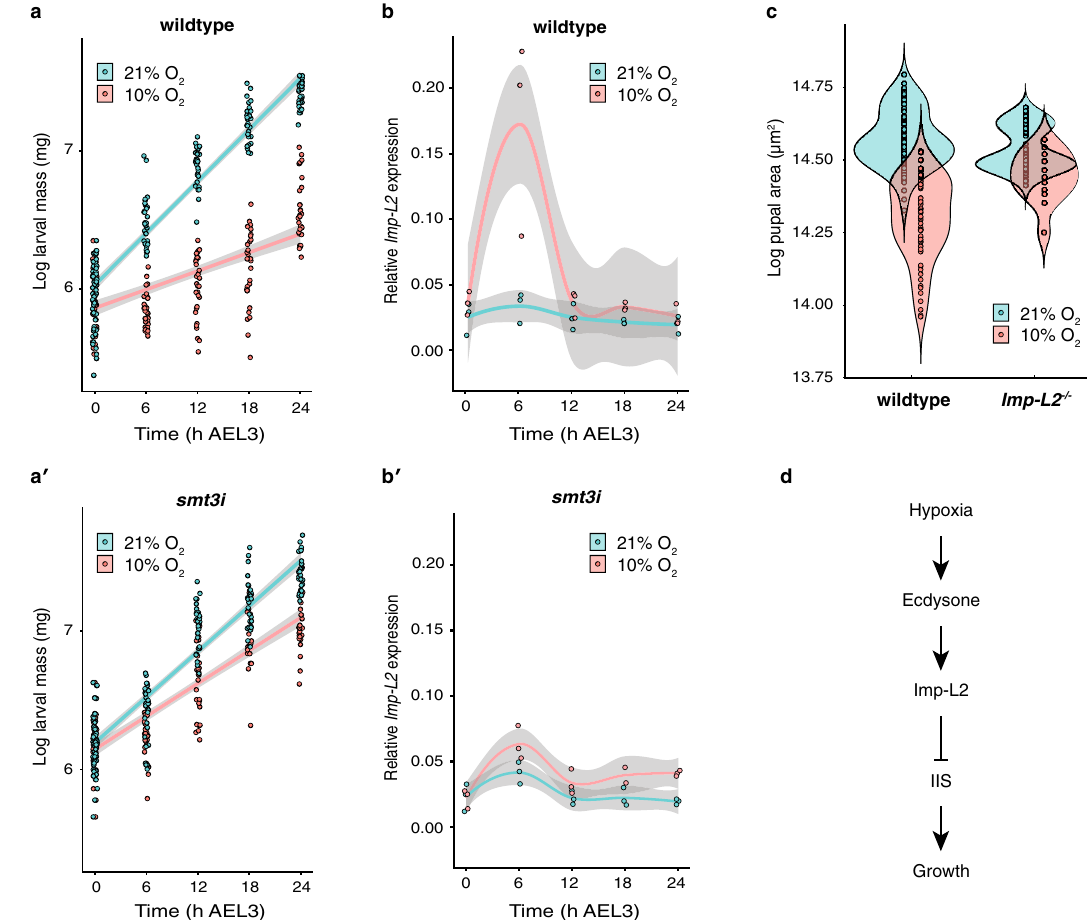
Figure 3. Suppression of ecdysone synthesis alleviates hypoxic growth reduction via Imp-L2 . ( a ) Growth rate of wildtype third instar larvae is substantially reduced in hypoxia relative to normoxic controls. ( a’ ) The effect of hypoxia on growth rate is significantly reduced in smt3i flies (GLM, P time*genotype*oxygen < 0.0001). ( b ) Expression of Imp-L2 is elevated 6 h AEL3 in wildtype hypoxic larvae. ( b’ ) Expression of Imp-L2 is reduced in smt3i hypoxic larvae. ( c ) Loss of Imp-L2 ( Imp-L −/− ), almost eliminates the effect of hypoxia on final body size ( t -test, P genotype*oxygen < 0.0001). ( d ) Model of the physiological mechanism by which hypoxia regulates growth and final body size in Drosophila . Grey bands are 95% confidence limits around the